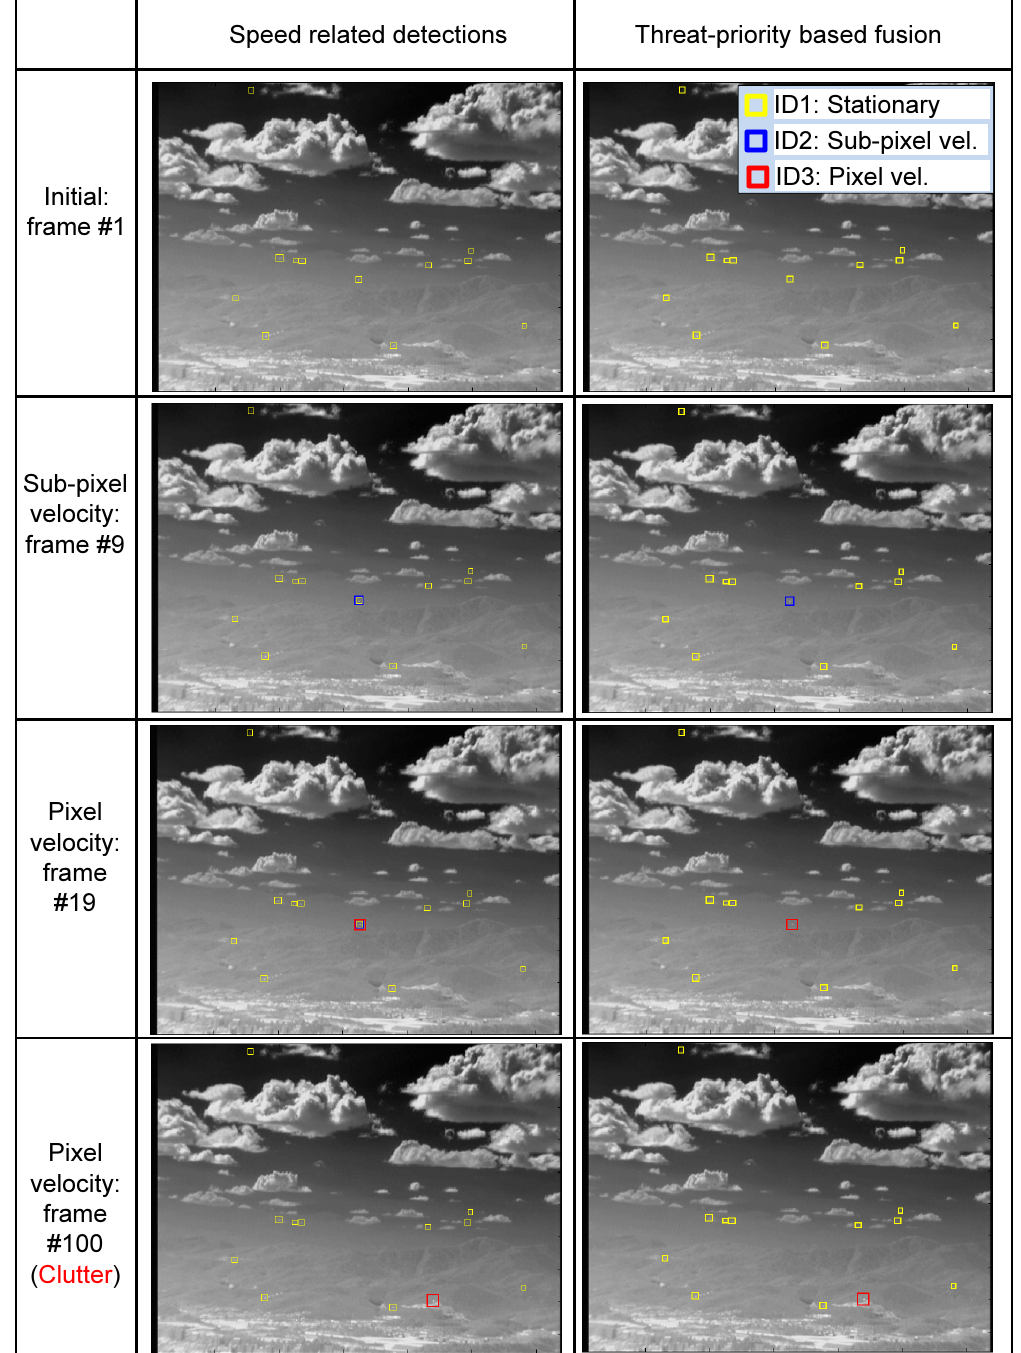
Figure 19. Examples of target detection using the proposed threat-priority-based detector fusion: ( Left ) before detector fusion; ( Right ) after detector